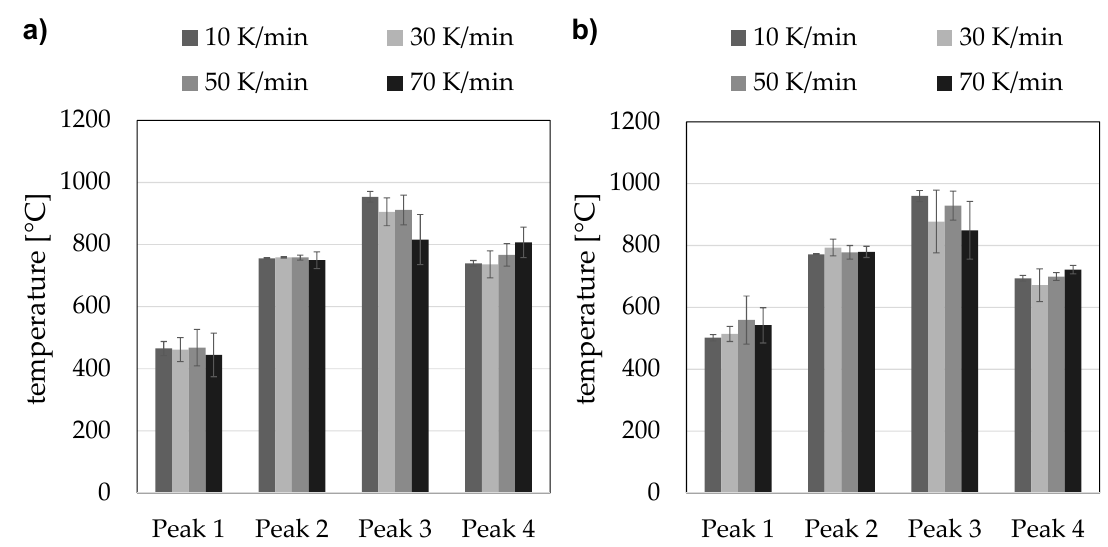
Figure 5. Temperatures for start ( a ) and end ( b ) of transformation peaks computed as arithmetic mean over a sample size of n (10 K/min) = 13, n (30K/min) = 16, n (50 K/min) = 14 and n (70 K/min) = 8.